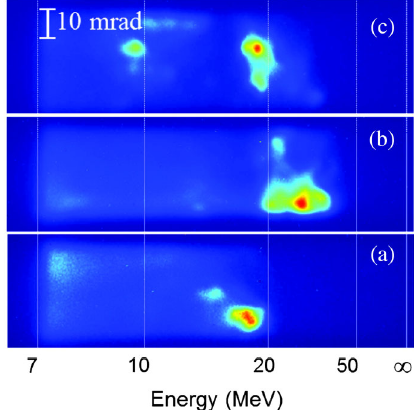
FIG. 5. Images of quasimonoenergetic electron spectra re- ’ 8 : 5 (cid:8) 0 : 5 (cid:3) 10 19 cm (cid:4) 3 , for different separations corded at n e of the laser pulse compressor gratings: (a) 0 (cid:3) m (45 fs), (b) (cid:4) 320 (cid:3) m (70 fs), and (c) (cid:4) 640 (cid:3) m (135 fs).